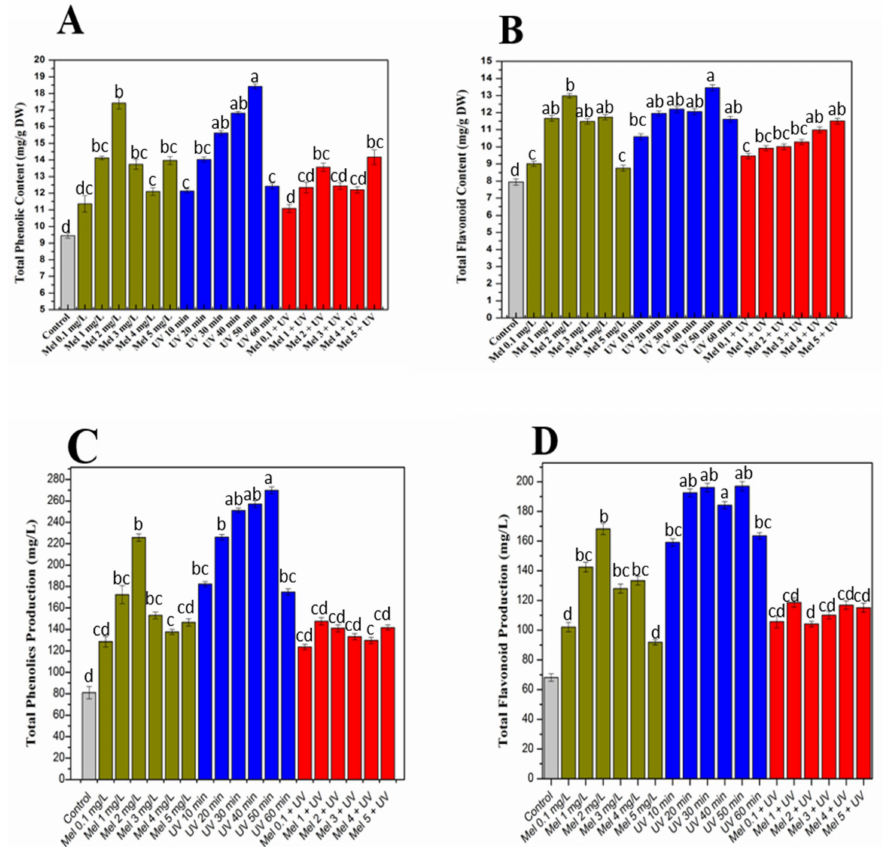
Figure 2. Total phenolic content (TPC), total flavonoid content (TFC) and their production at optimized hormonal conditions under di ff erent treatments of UV-C, melatonin and Mel + UV-C. ( A ) TPC (mg / g DW), ( B ) TFC (mg / g DW), ( C ) total phenolic production (TPP) (mg / L) and ( D ) total flavonoid production (TFP) (mg / L). Values are means ± SE from triplicates. Columns with similar alphabets are not significantly di ff erent ( p < 0.05), according to Tukey’s